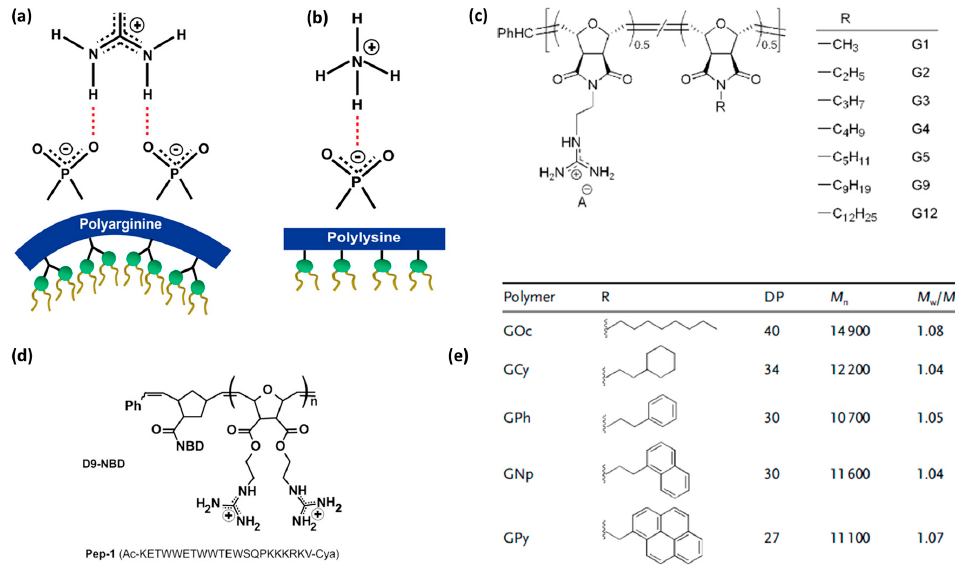
Figure 4. Schematic representation of the ( a ) bidentate and ( b ) monodentate hydrogen bonding interaction of the guanidinium group of the arginine and of the lysine side chain, respectively, with the membranes, taken in part from reference [87]; ( c ) Example of CPP mimetics containing a combination of guanidinium and aliphatic groups of various lengths (from methyl to dodecyl), used to improve internalization efficiency by mimicking the hydrophobic counterion effect